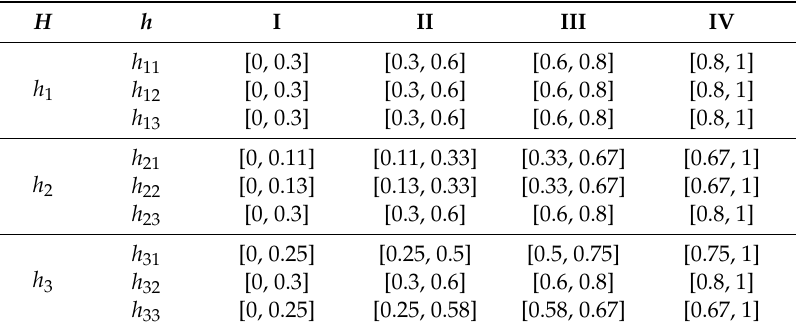
Table 2. Normalized value of subattributes of